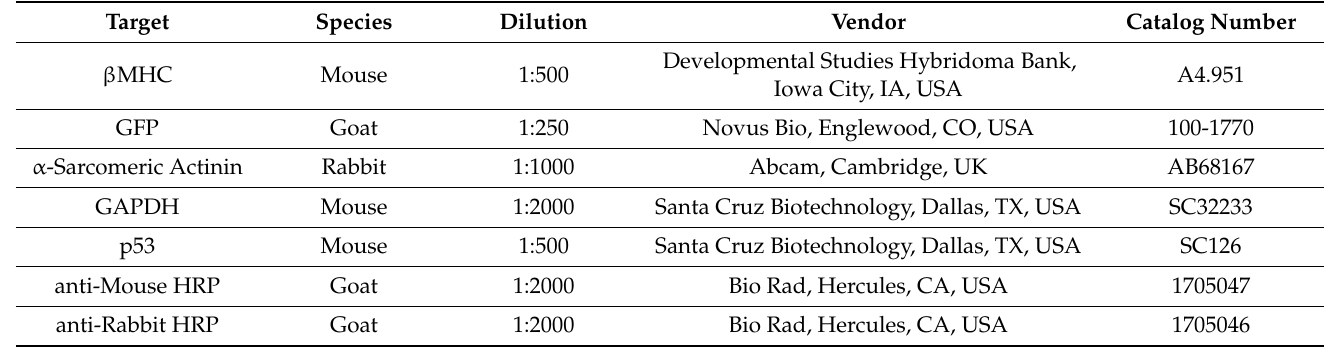
Table 4. Western blot